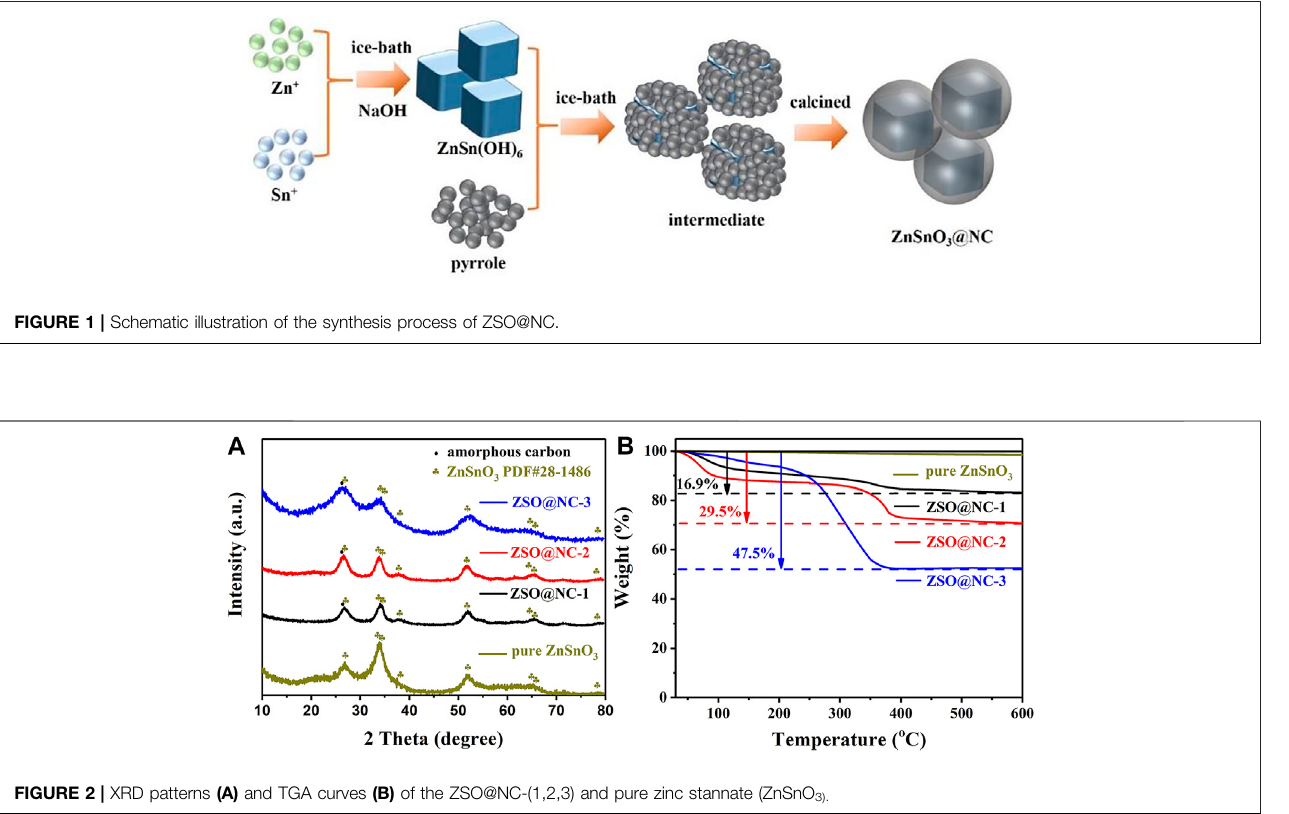
Frontiers in Chemistry |